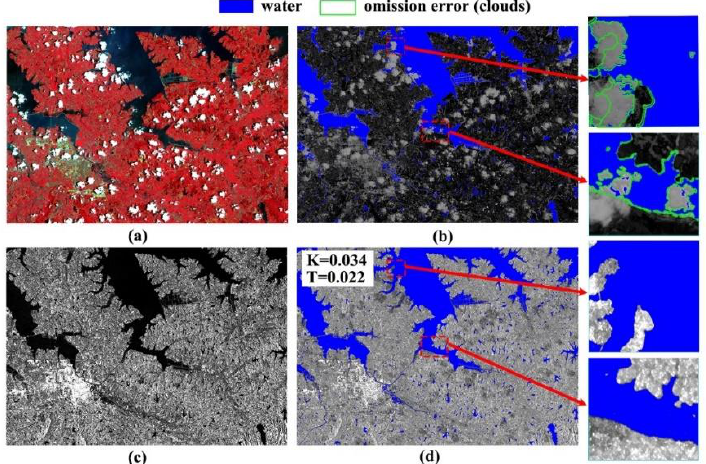
Figure 8. Results of the water extraction in the Junshan Lake area under the occlusion of clouds and fog: ( a ) Optical image. ( b ) Water extraction based on the NDWI. ( c ) SAR image. ( d ) Water extraction based on the SOWI.